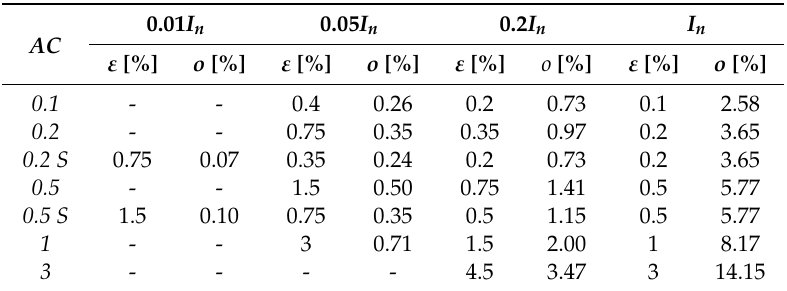
Table 3. Results for measuring purpose LPCTs.